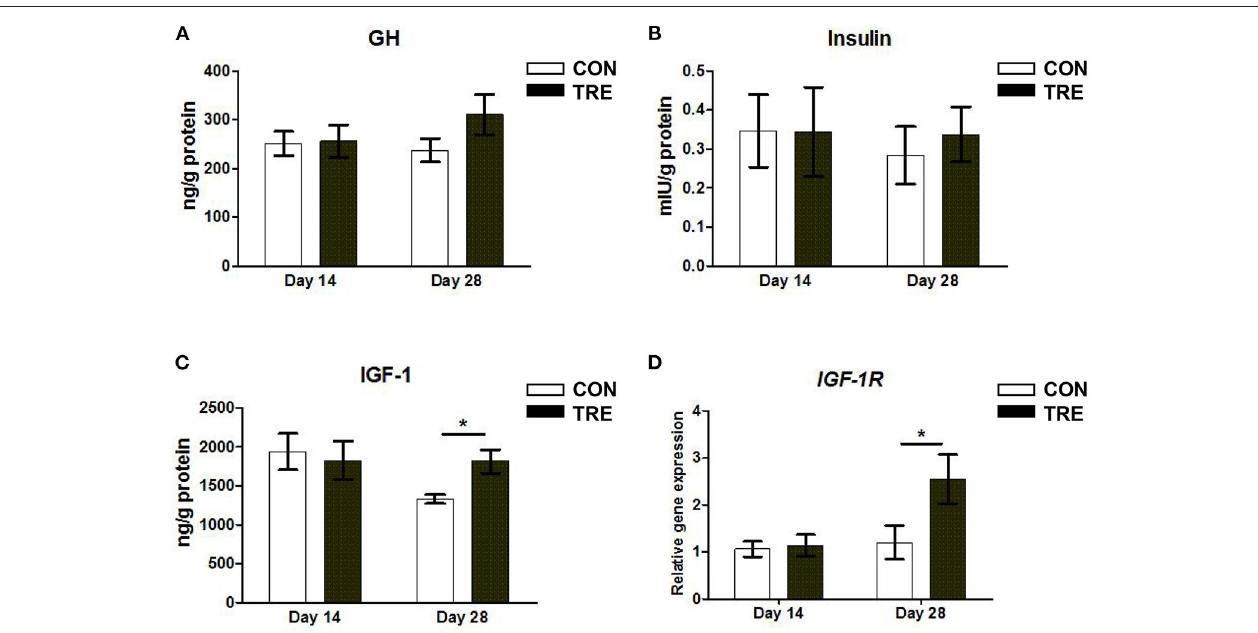
FIGURE 1 | Effect of protein restriction and succedent realimentation on hormone contents and insulin-like growth factor-1 receptor gene expression of jejunum in weaned piglets ( n = 6). (A) Concentration of growth hormone (GH) in jejunal mucosa on day 14 and 28. (B) Concentration of insulin in jejunal mucosa on day 14 and 28. (C) Concentration of insulin-like growth factor-1 (IGF-1) in jejunal mucosa on day 14 and 28. (D) Alterations of IGF-1 receptor ( IGF-1R ) gene expression in jejunal mucosa on day 14 and 28. p < 0.05 were considered significant and markers (*) between groups on the same day. CON, control group; TRE, treatment